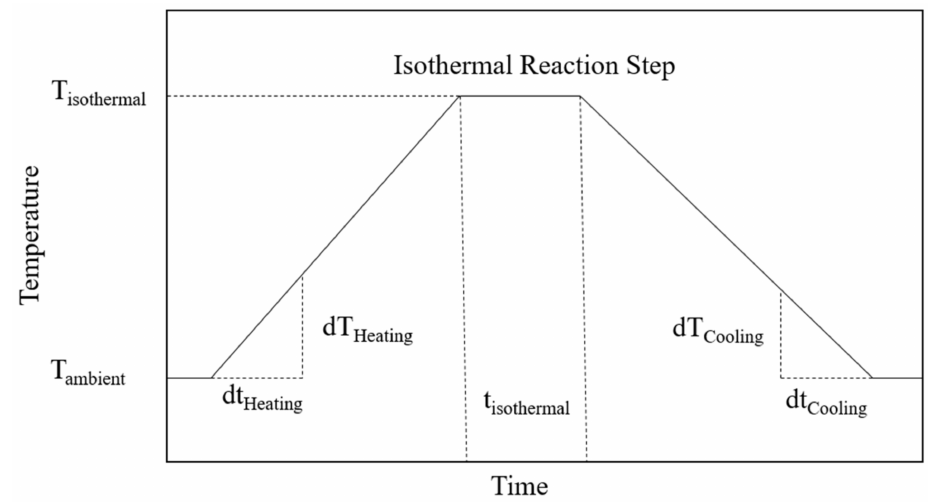
Figure 3. Illustration of the temperature profile and underlying metrices applied for DSC measurements.